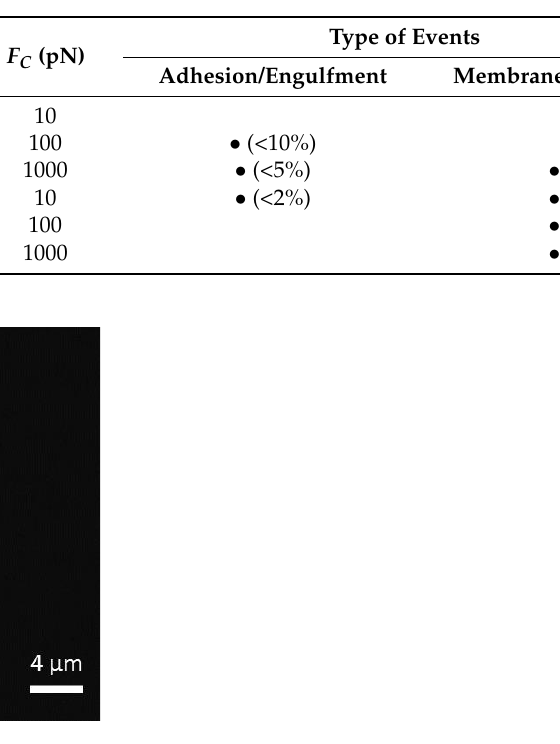
Figure 4. Fluorescence image of a bare (non-fluorescent) silica colloid after GUVs centrifugation at F C ≈ 1000 pN. Fluorescent regions on the particles are due to the adsorption of lipids onto silica.